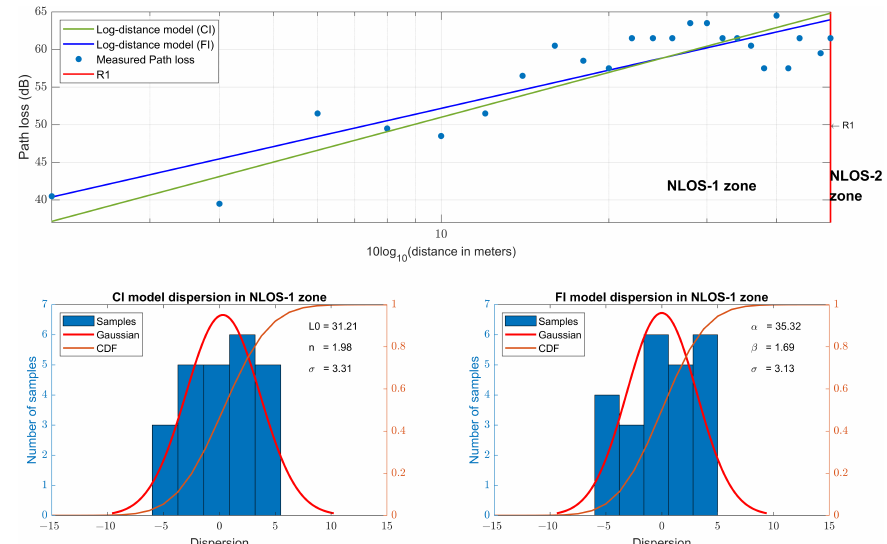
Figure 9. Zigbee RSSI path loss models at 868 MHz and their